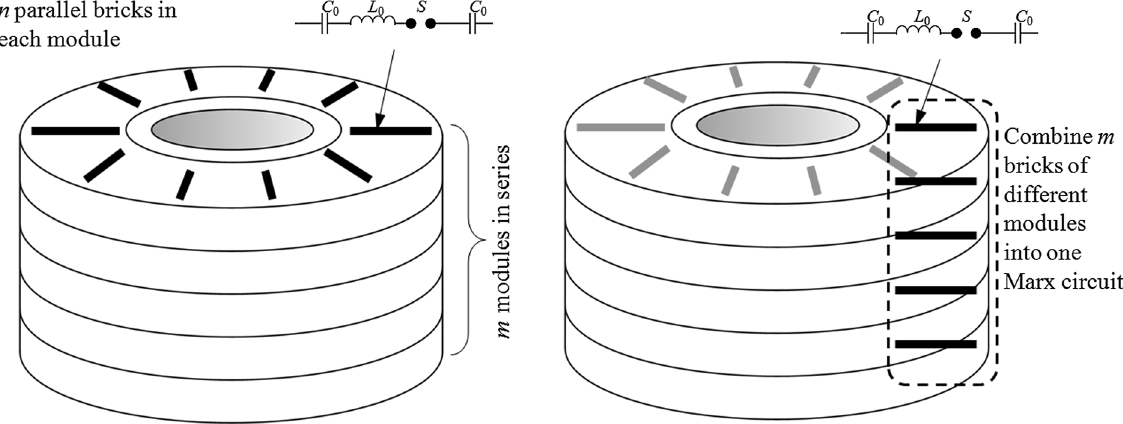
FIG. 3. Construction of hybrid mode LTD